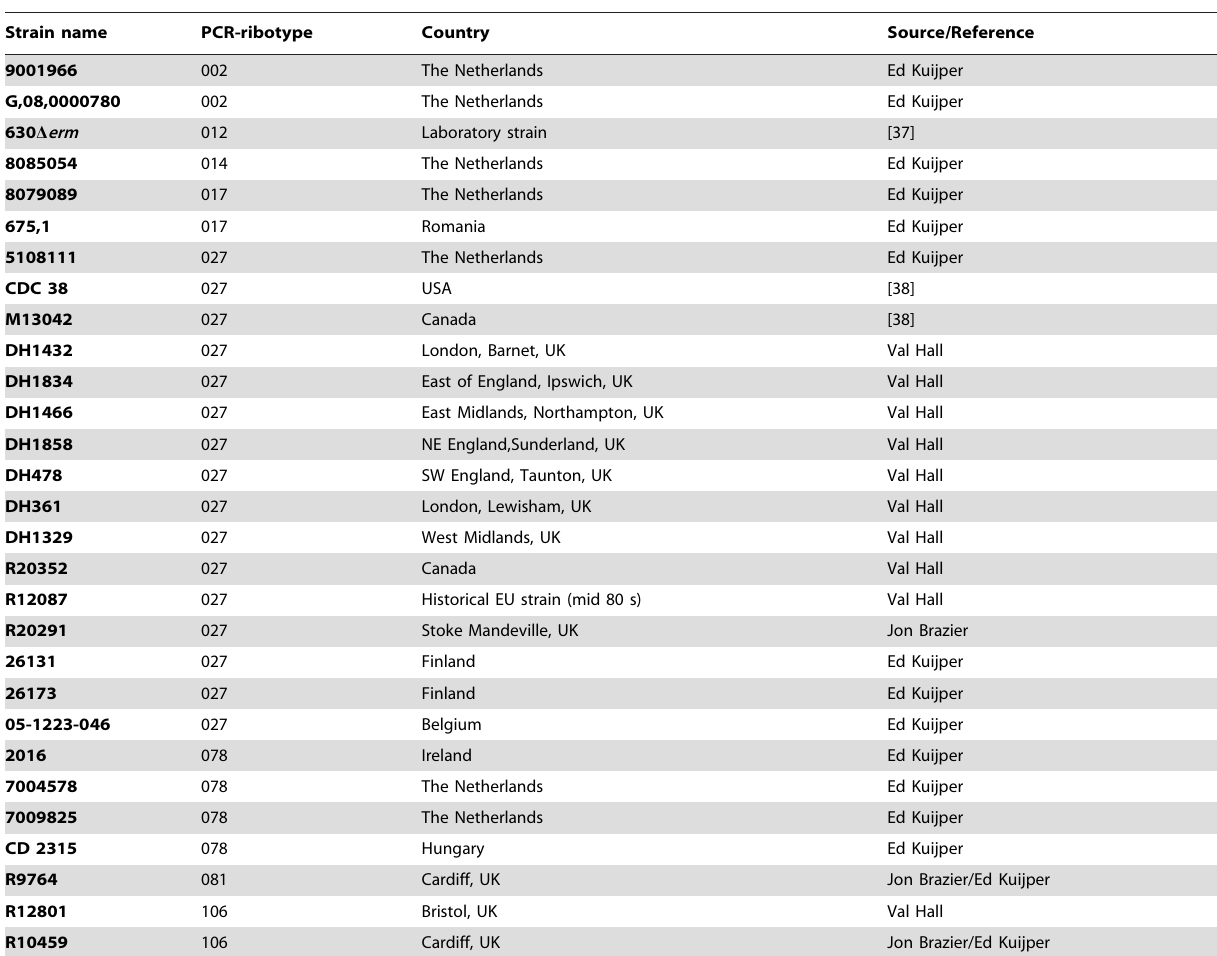
Table 1. C. difficile strains used in this